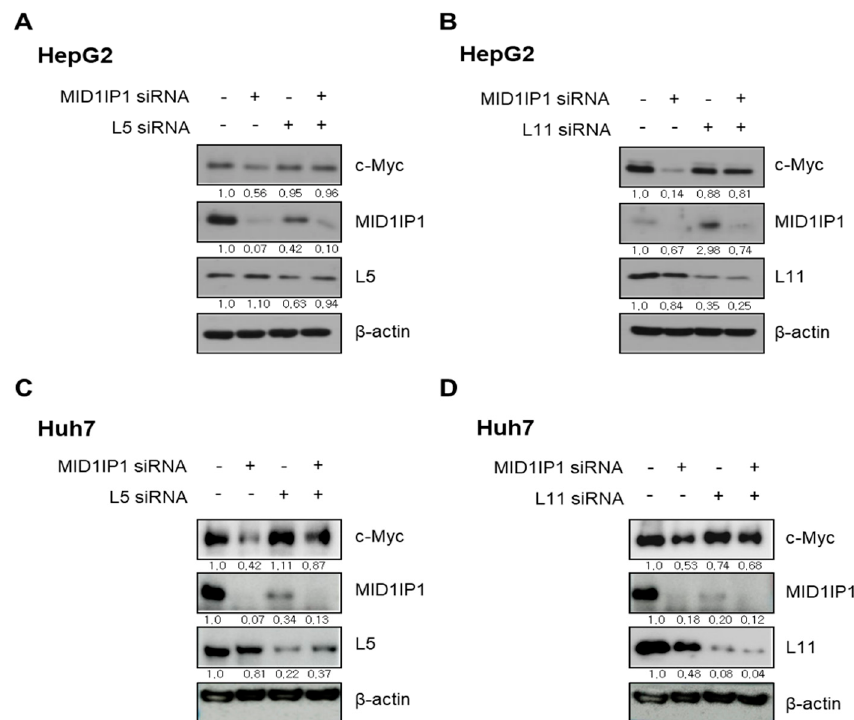
Figure 6. Effect of ribosomal protein L5 or L11 on c-Myc in MID1IP1 depleted HepG2 and Huh7 cells. ( A ) Effect of RPL5 depletion on c-Myc in MID1IP1 depleted HepG2 cells. ( B ) Effect of RPL11 depletion on c-Myc in MID1IP1 depleted HepG2 cells. ( C ) Effect of RPL5 depletion on c-Myc in MID1IP1 depleted HepG2 cells. ( D ) Effect of RPL11 depletion on c-Myc in MID1IP1 depleted HepG2 cells. − , untreated; + , treated. Values of Western blot images represent relative level of protein expression / β -actin.